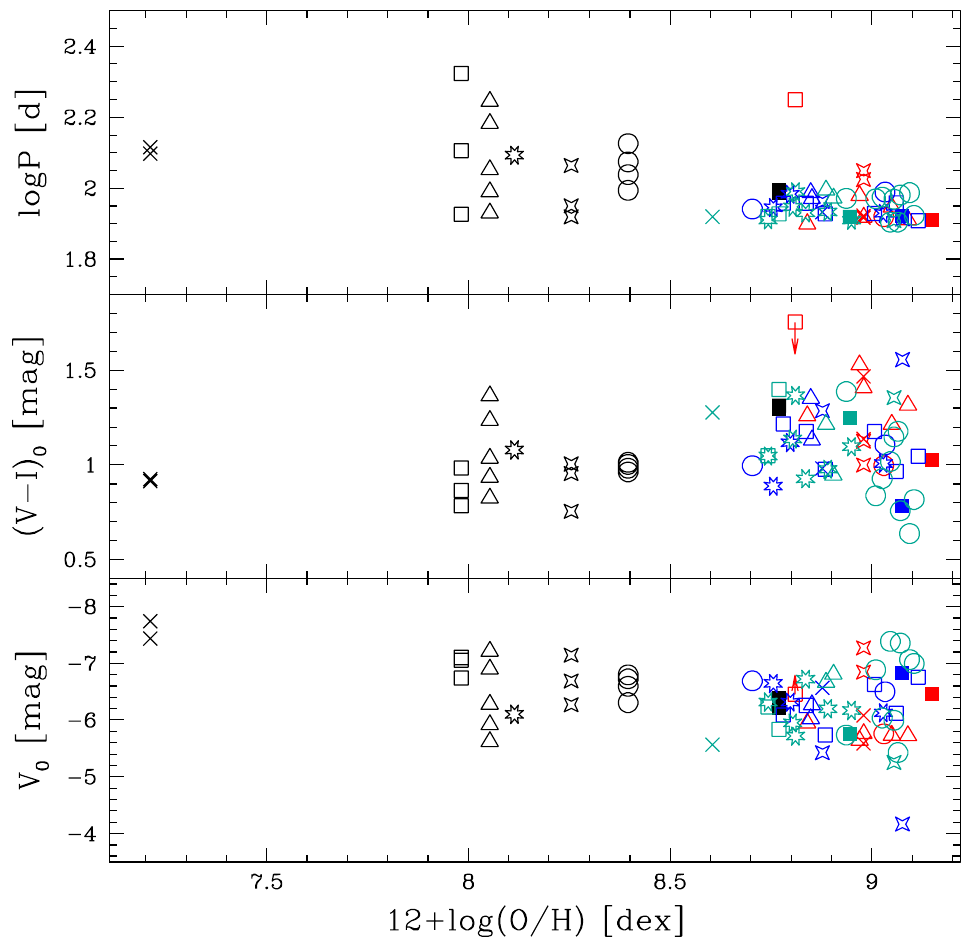
Figure 5. Dependence on the metal abundance of period (upper panel), absolute color (middle panel) and magnitude (bottom panel) of the ULPs in Table 1. The adopted symbols for the ULPs are the same in Figure 1, whereas the red arrow is explained in Figure